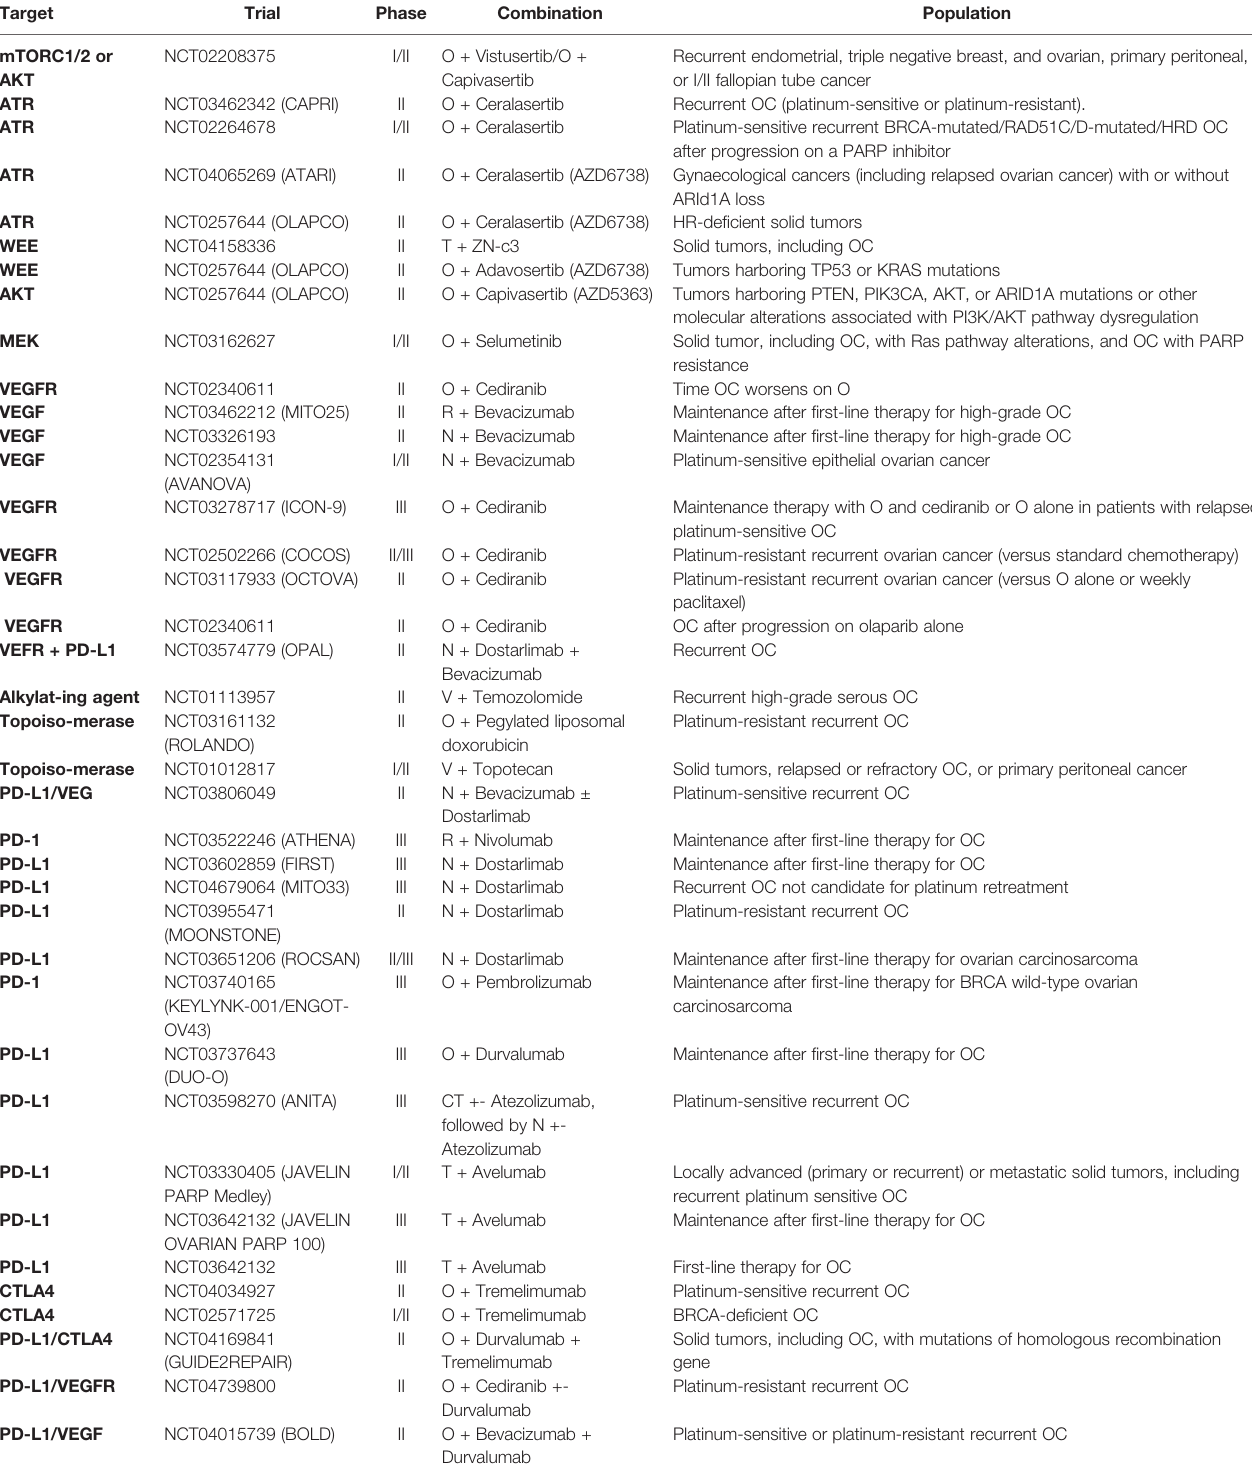
TABLE 2 | Ongoing phase II-III studies of PARP inhibitor combinations.